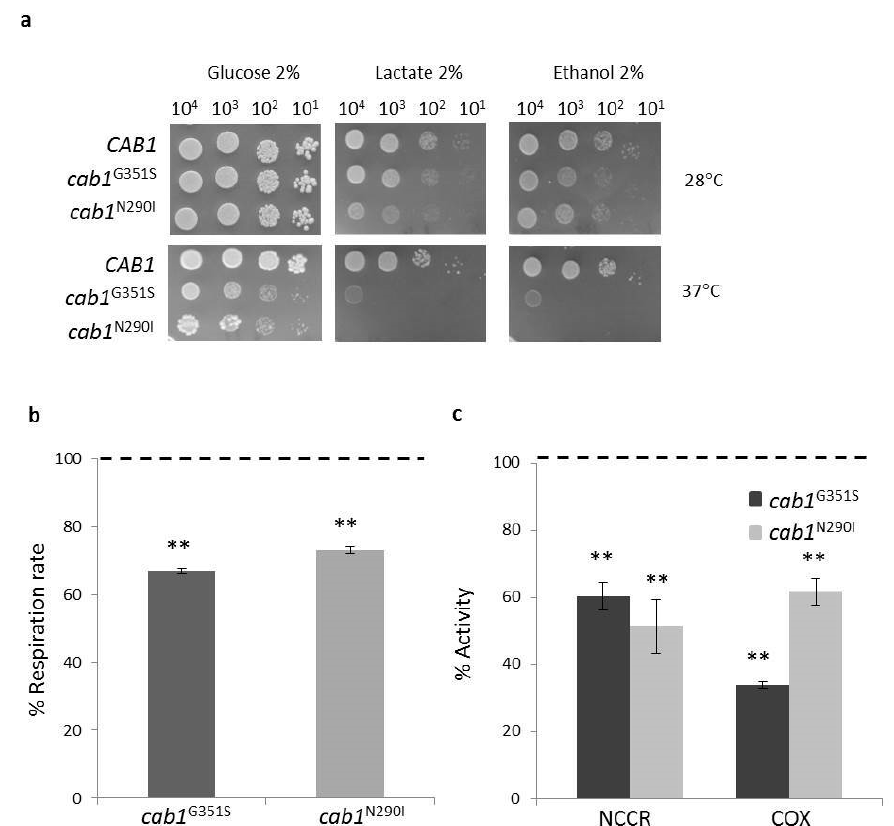
Figure 2. ( a ) Oxidative growth phenotype. Equal amounts of serial dilutions of cells from exponentially grown cultures (10 4 , 10 3 , 10 2 , 10 1 cell/spot) were spotted onto SC medium supplemented with the indicated carbon. The growth was scored after 3–5 days of incubation at 28 ◦ C and 37 ◦ C. The experiment was performed on at least three independent clones for each strain. ( N = 2; n = 6). ( b ) Oxygen consumption rate (OCR) was measured in wild-type and mutant strains. ( c ) NADH-cytochrome c oxidoreductase (NCCR) and cytochrome c oxidase (COX) activities were measured in mitochondria extracted as described in Material and Methods. OCR and mitochondrial enzyme activities were normalized to the strain transformed with the CAB1 wild-type allele. Values are means ± standard deviation. N = 3; n = 9 for each strain. **: p < 0.01.